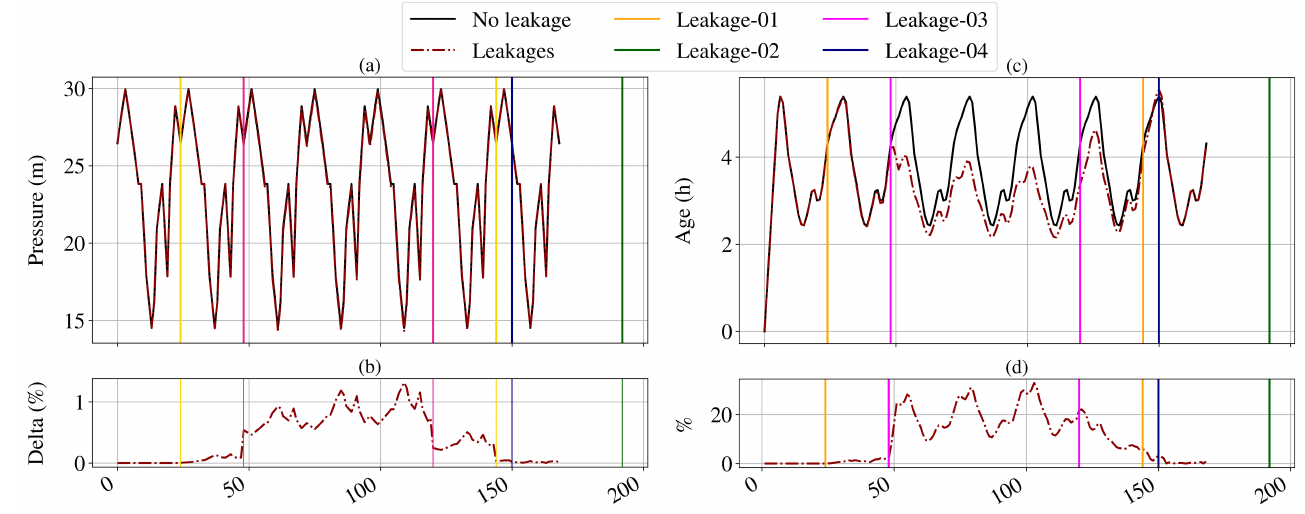
Figure 4. Sensitivity of node 104 for leaks in scenario A: ( a ) Pressure variation, ( b ) Pressure variation delta, ( c ) Quality variation and ( d ) Quality variation delta.